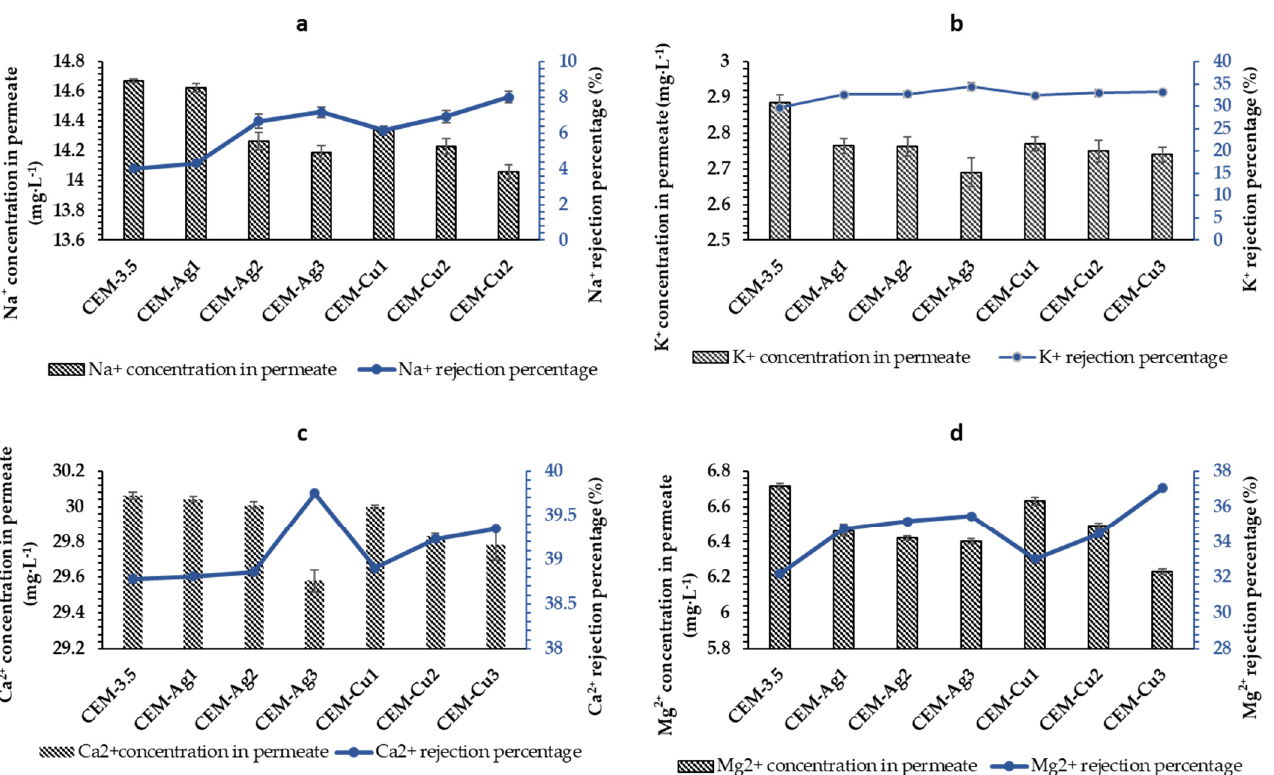
Figure 7. Cation rejection percentage of pristine CEM-3.5, Ag- and Cu-functionalized CEM-3.5 at 0.5 bars in a dead-end filtration system, and concentration value of cation in permeate: ( a ) Na + , ( b ) K + , ( c ) Ca 2+ , and ( d ) Mg 2+ .